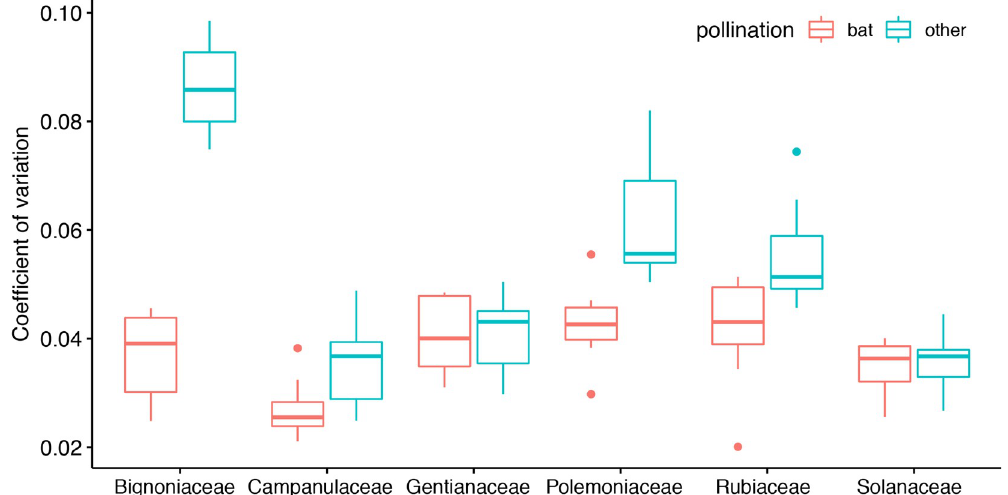
Fig 5. Coefficients of variation of acoustic features of the echoes of flowers from twelve plant species from six different families. Orange: bat-pollinated species. Petrol: bird-or insect-pollinated species. For each species, we analysed the variation of the average target strength of four frequency bands for two scans (each with 101 measurements). We analysed a 45 kHz, 68 kHz, 102 kHz and a 153 kHz frequency band. Upper and lower boundary of the bands where ± 20% around these centre